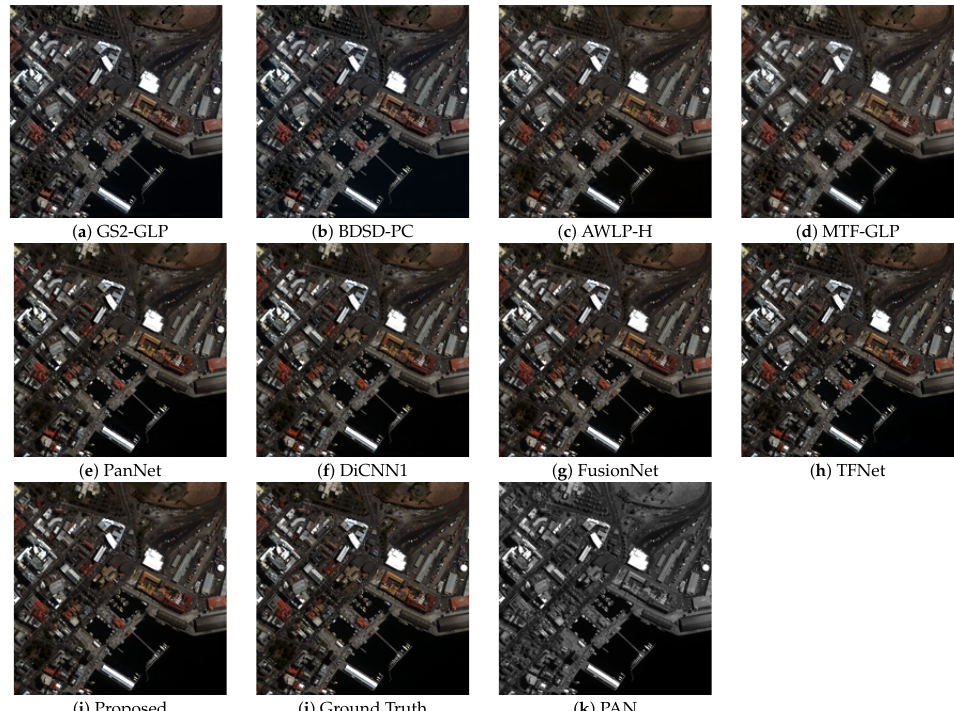
Figure 2. Fusion results of a group of reduced resolution samples on the Ikonos dataset. Table 6. Comparison of indicator evaluation results on the reduced-resolution Ikonos